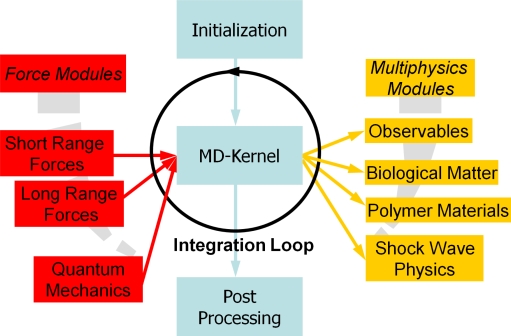
Design schematic of the particle-based multiscale simulation package “MD-Cube” at EMI. A kernel takes care of administrative tasks. Force modules can be added via defined interfaces as well as modules for the demands of different physical applications.